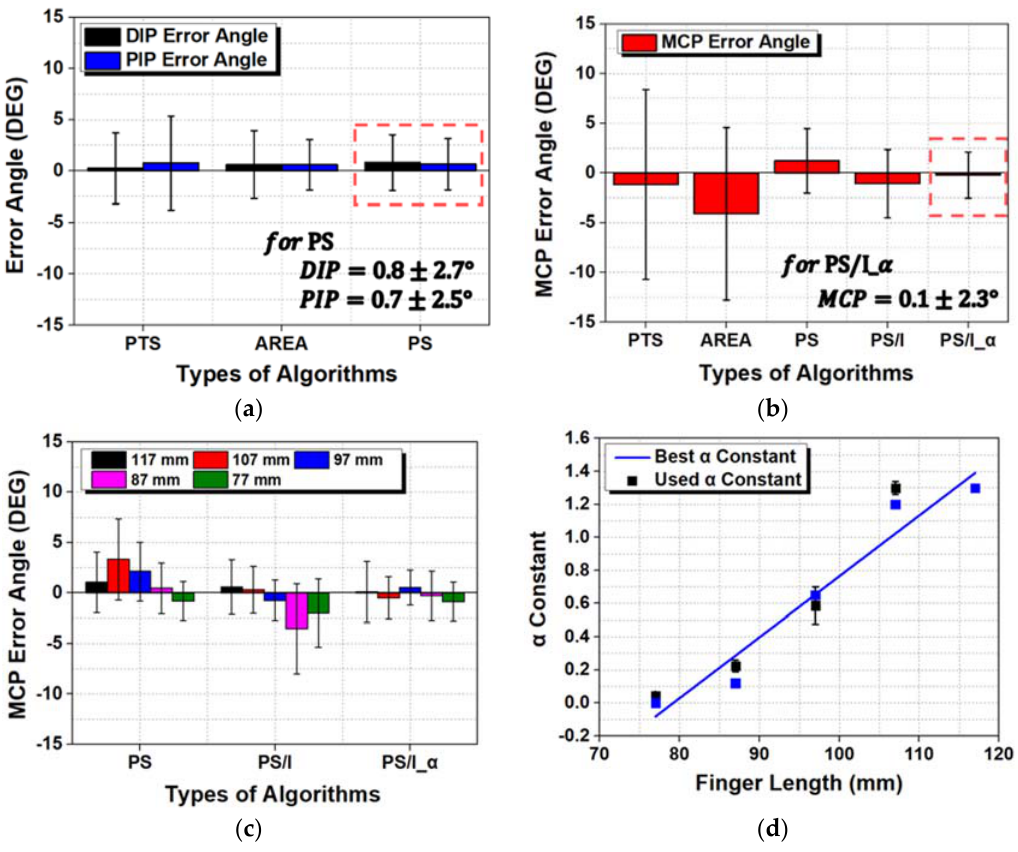
Figure 9. Joint angle errors of the wearable hand module according to different lengths of the index ‐ little fingers: ( a ) Distal interphalangeal (DIP) and proximal interphalangeal (PIP) joint angle errors, ( b ) MCP joint angle error, and ( c ) MCP joint angle error according to the lengths of the index ‐ little fingers, and ( d ) best and used α constant values for accurate measurement of the MCP